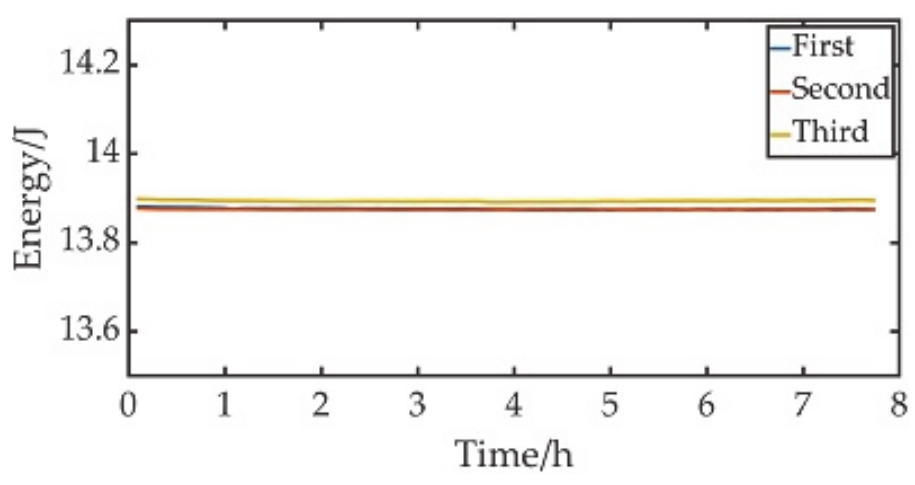
Figure 11. The output voltage of PD in Experiment 1.